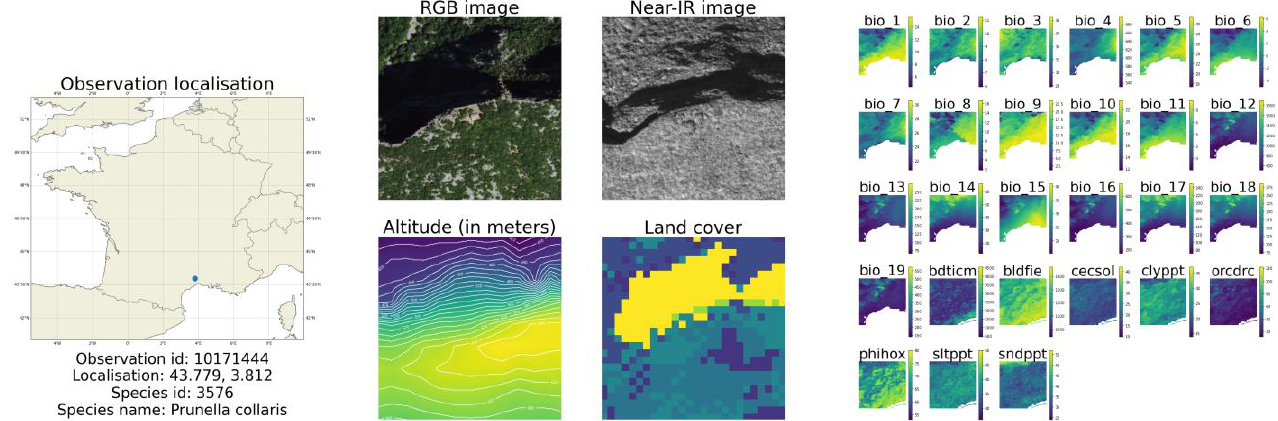
Figure 4. The observation data of the location [43.779, 3.812] in GeoLifeCLEF 2021.